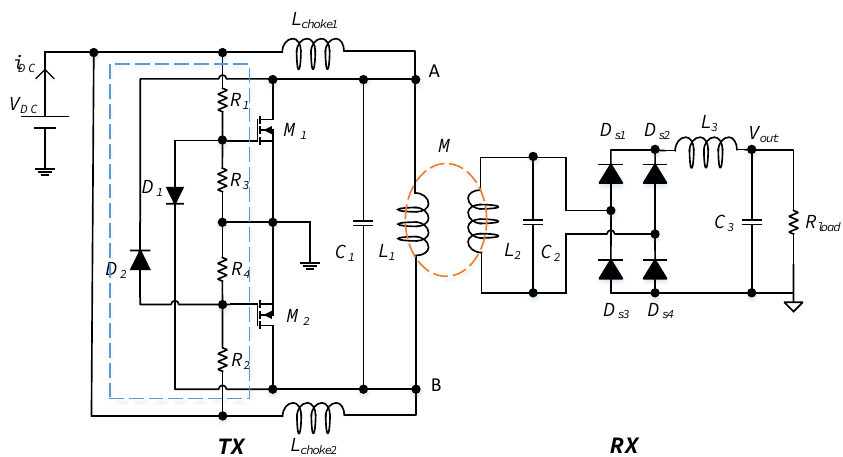
Figure 1. The schematic of a traditional autonomous current-fed push-pull inductive power transfer (IPT) system.